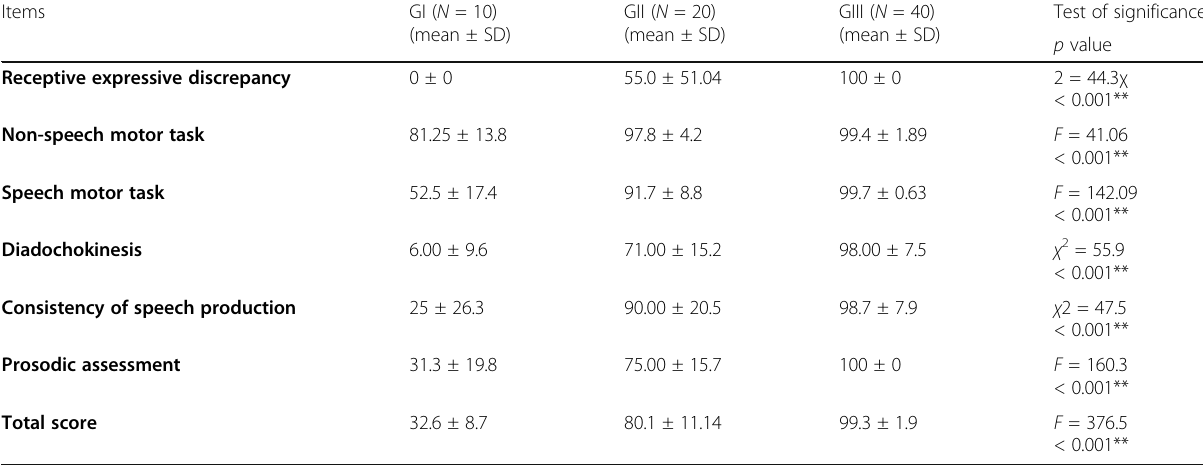
Table 5 Comparison between the three groups in their performance on CAS test battery Items